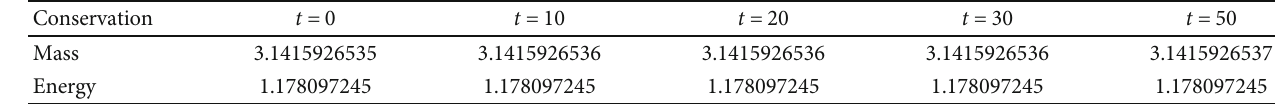
Table 5: The conservation of mass and energy for Example 2.